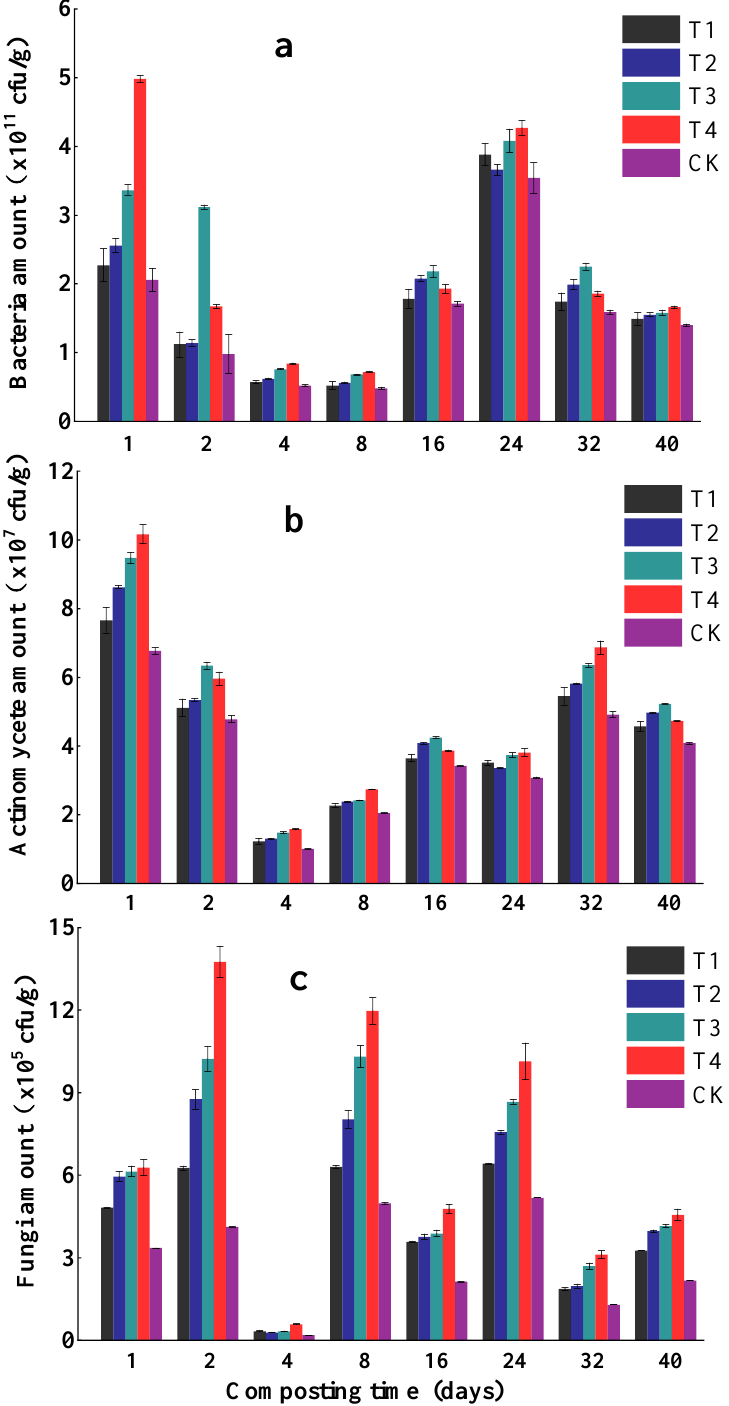
Figure 4. Microbial population of different treatments during the composting process. Bacteria ( a ), actinomycetes ( b ), and fungi ( c ).